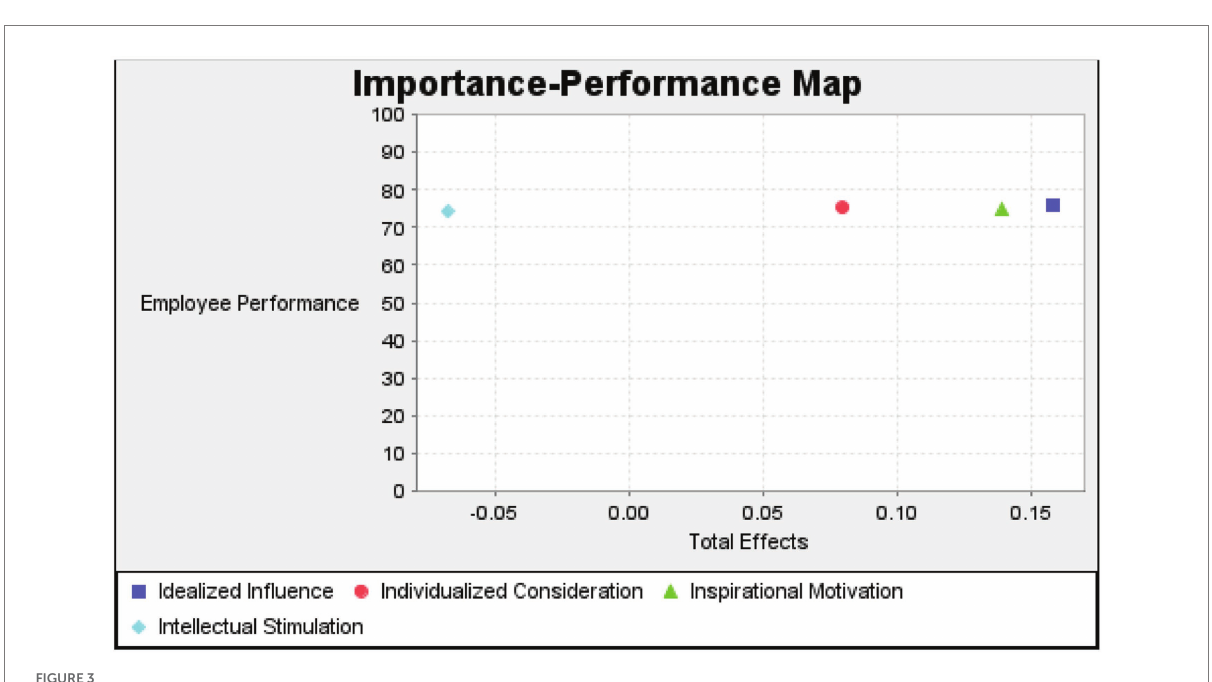
FIGURE 3 Importance performance map of employee